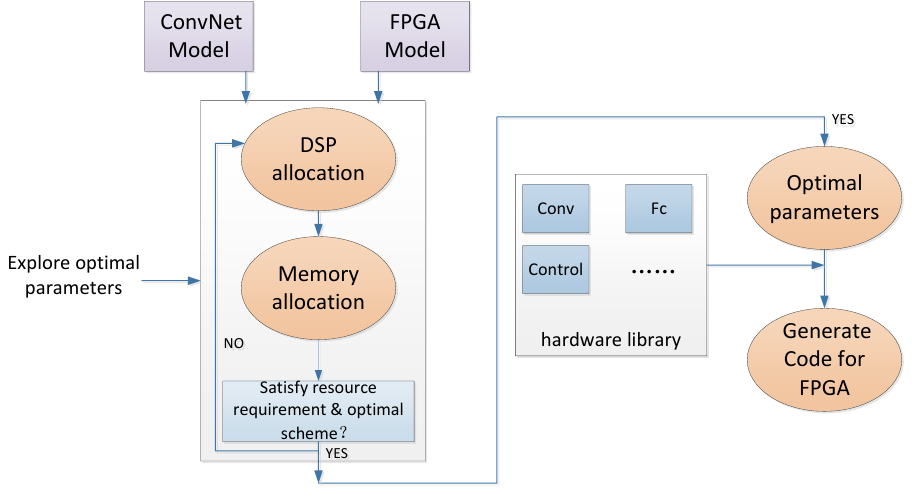
Figure 8. End-to-end flow.